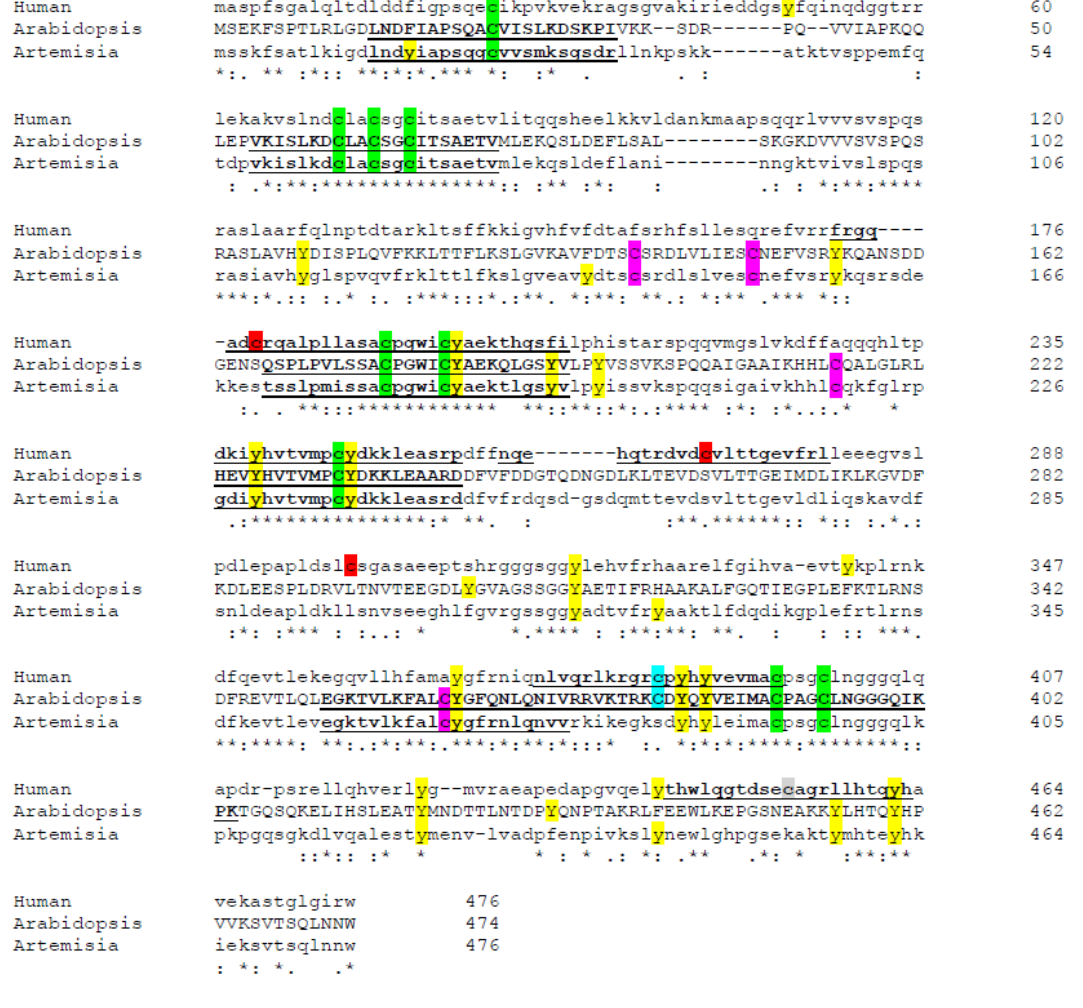
Figure 1. Amino acid sequence alignments of hydrogenases. Clustal Omega [50] was used to align three hydrogenase sequences: human cytosolic iron-sulfur assembly component 3 isoform